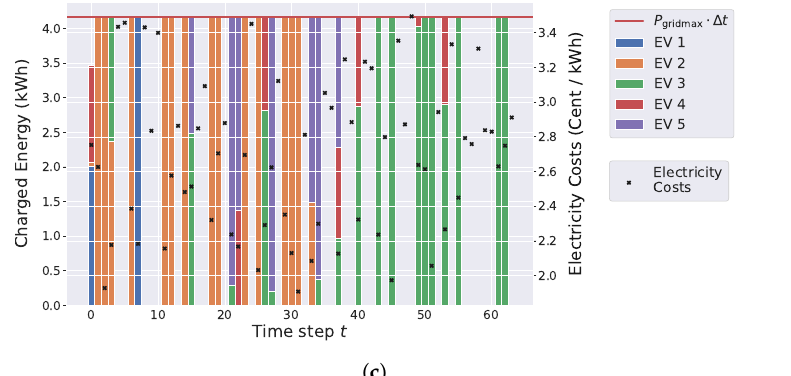
Figure 5. Optimal solution for an instance with n = 5, ∆ t = 5min, P gridmax ∈ { 50,125,200 } kW using EVS-SOC-GLIN. ( a ) P gridmax = 200kW; total charging costs: 290.42cent. ( b ) P gridmax = 125kW; total charging costs: 296.91cent. ( c ) P gridmax = 50 kW;total charging